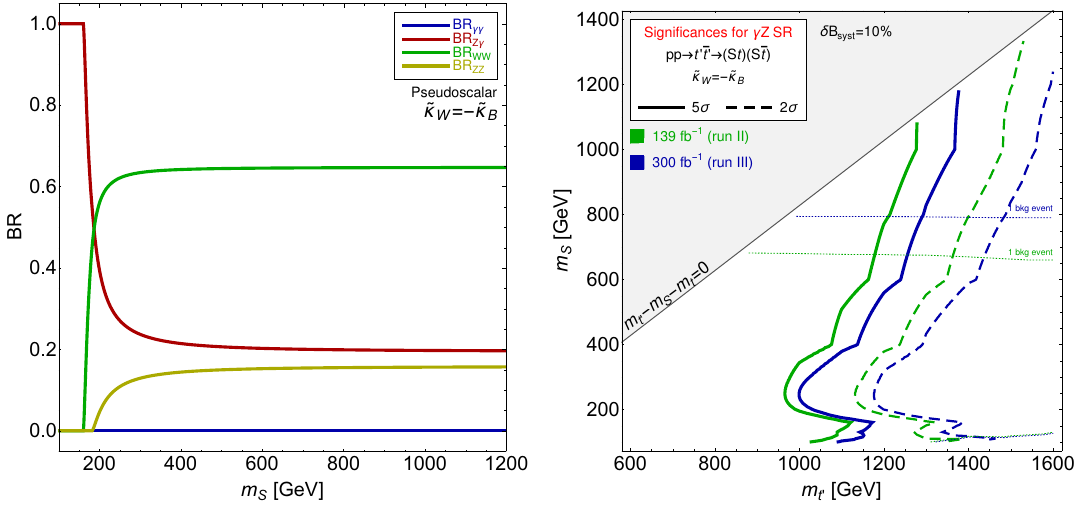
Figure 11 . Left panel: BRs of S resonance into EW bosons for the pseudoscalar case ( (cid:20) B = (cid:20) W = 0) in the photophobic S case (~ (cid:20) B = (cid:0) ~ (cid:20) W ). Right panel: LHC reach for di(cid:11)erent LHC luminosities; the meaning of contours is the same as in (cid:12)gure